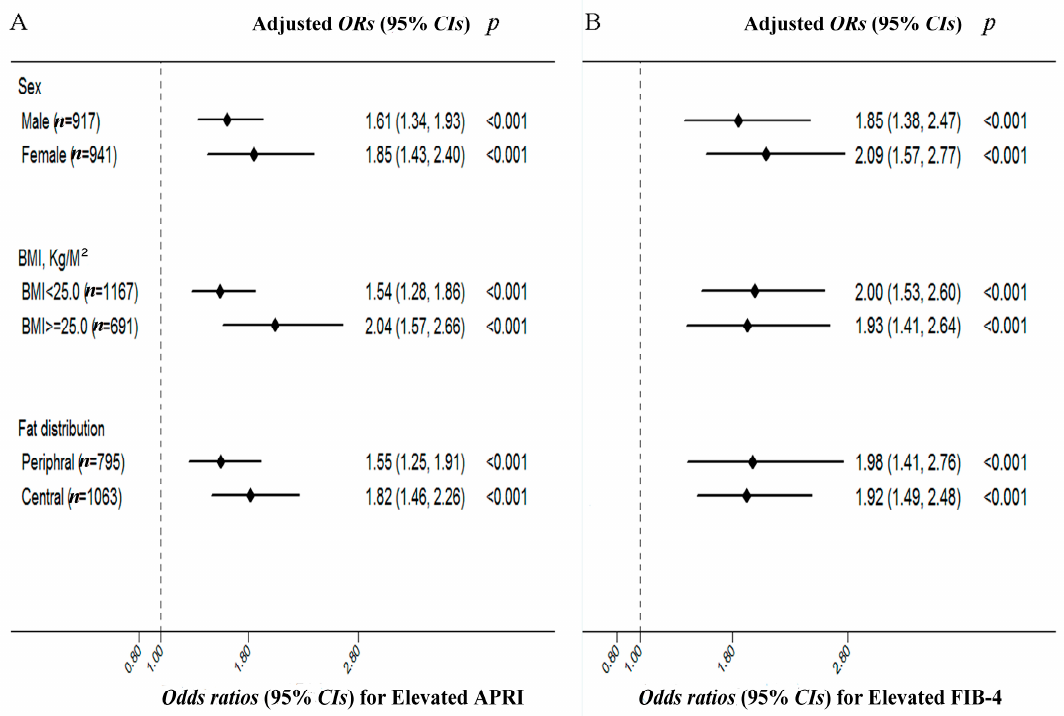
Figure 1. The risks of elevated APRI ( A ) and FIB-4 ( B ) with each 1 SD increase in serum DBil among HBsAg(+) participants. The risks of elevated APRI ( A ) and FIB-4 ( B ) with each 1 SD increase in serum DBil concentrations according to subgroups of sex (male vs. female), overweight (BMI < 25.0 vs. ≥ 25.0 kg/m 2 ), fat distribution (WHR ≥ 0.92 for male and WHR ≥ 0.81 for female vs. WHR < 0.92 for male and WHR < 0.81 for female). Adjusted for age (continuous), sex (male, female), BMI (continuous), WHR (continuous), smoking (never smoking, quit smoking, current smoking), drinking (never drinking, quit drinking, current drinking), education ( ≤ 6/7–9/10–12/ ≥ 13), marriage status (yes/no), physical activity (yes/no) and medical history (yes/no for hypertension, CHD, diabetes, fatty liver). APRI, aspartate transaminase to platelet ratio index; FIB-4, Fibrosis 4 score; SD, standard deviation; WHR, waist-to-hip ratios; ORs, odds ratios; CIs, confidence intervals.